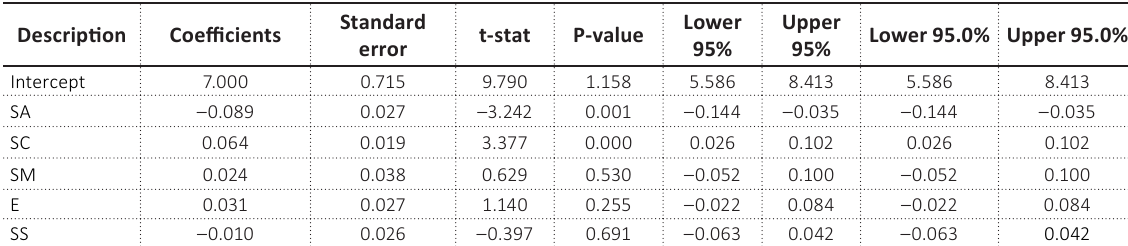
Source: Data analysis.